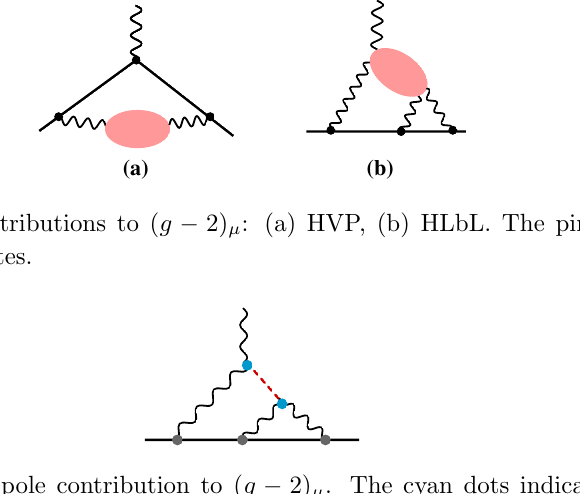
Figure 2. Pseudoscalar-pole contribution to ( g (cid:0) 2) (cid:22) . The cyan dots indicate the TFF of the pseudoscalar